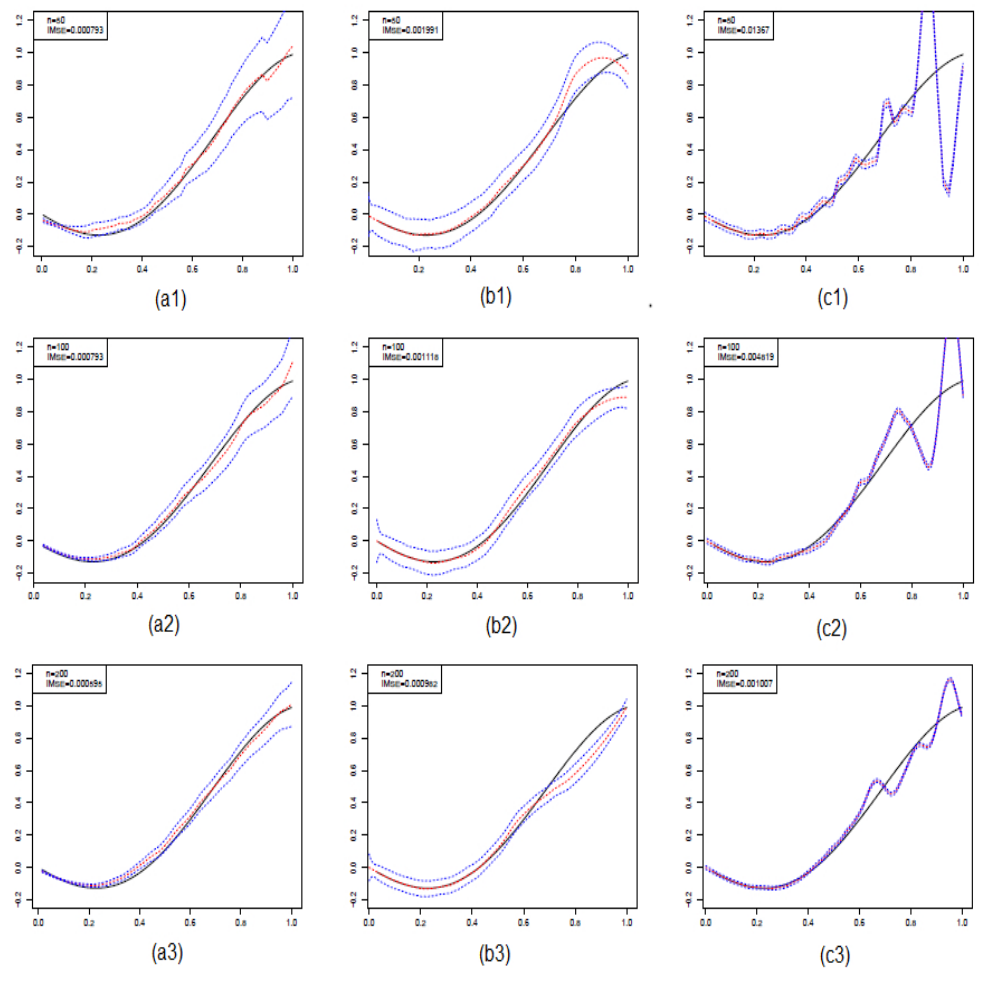
Figure 2. Solid line: true curve; dotted middle blue line: estimated curve; dotted lower and upper blue lines: 95% confidence bands. The first, second and third rows are for sample size of 50, 100 and 200, respectively. In each row, the left panel is the proposed method, the middle panel is the local linear smoother and the right panel is the spline